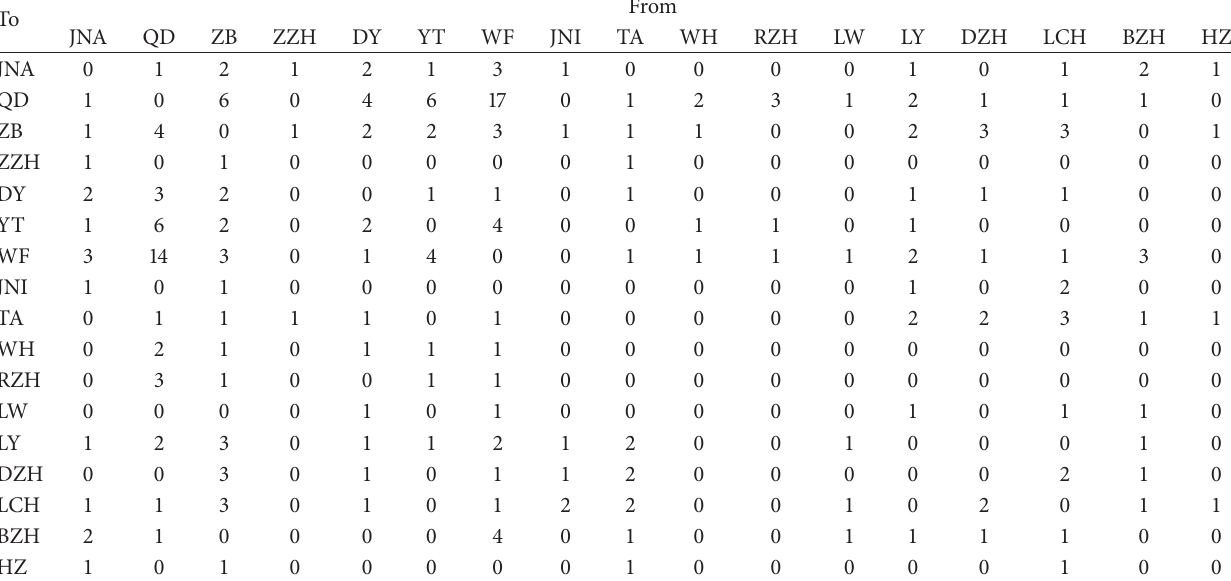
Table 4: The freight flows between two cities (unit: loaded-semitrailer). To